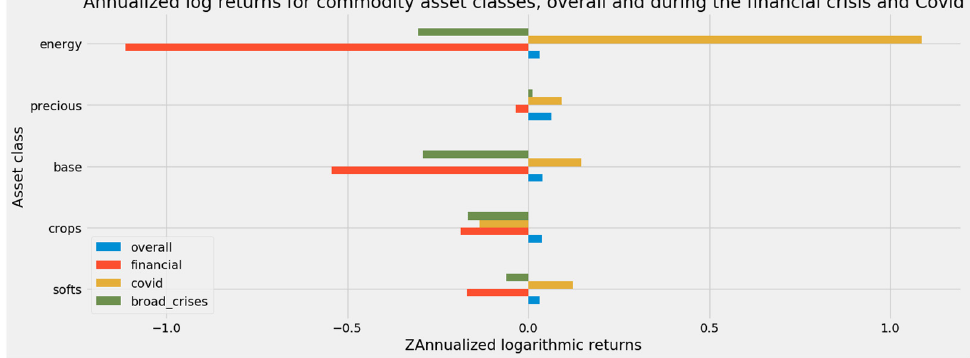
Figure 44. Annualized logarithmic returns for commodity asset classes, overall and during the financial crisis of 2008–2009 and the COVID-19 pandemic.